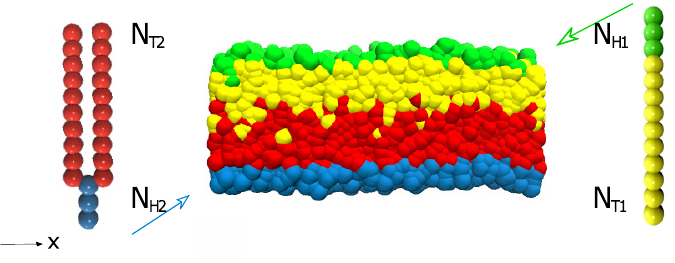
Figure 1. Two types of lipid molecules and the asymmetric structure are displayed in the schematic diagram. An example of the asymmetric membrane formed by these two types of lipids is exhibited in the